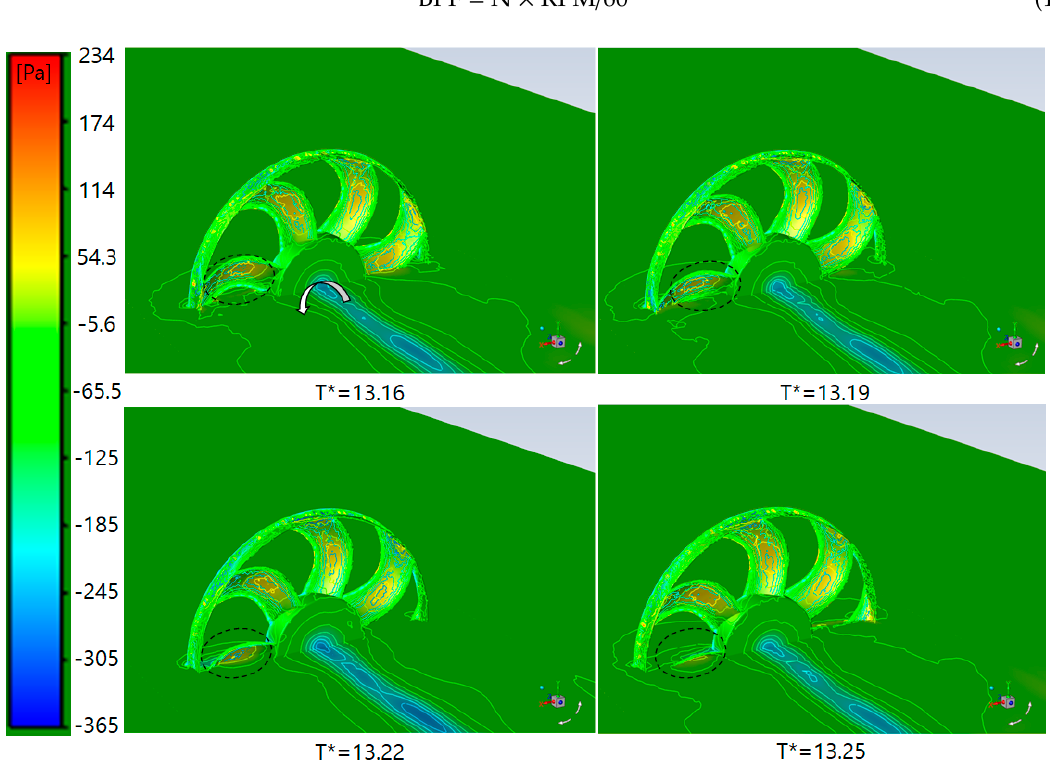
Figure 10. Pressure contours on the pressure side of the fan’s blades an in the wake region at y = 0 section at different dimensionless times of T* = 13.16, 13.19, 13.22, and 13.25.